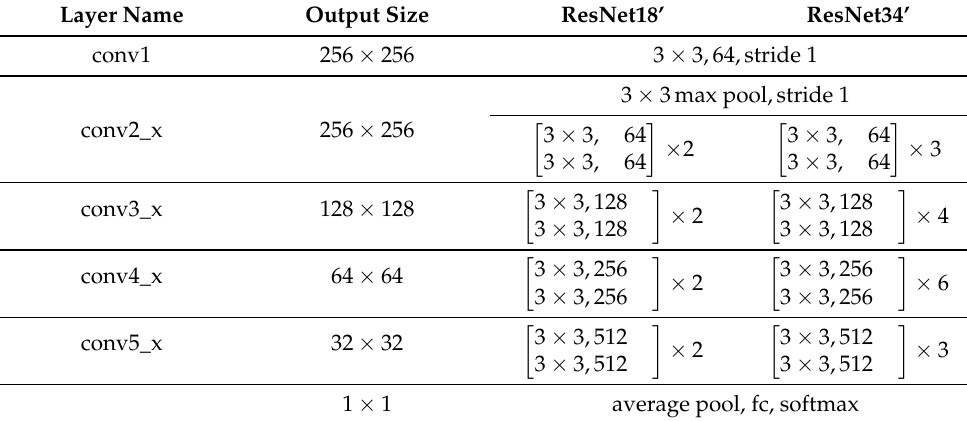
Figure 5. Architecture of the residual block. Table 3. Architectures of ResNet18’ and ResNet34’ with input size of 256 ×